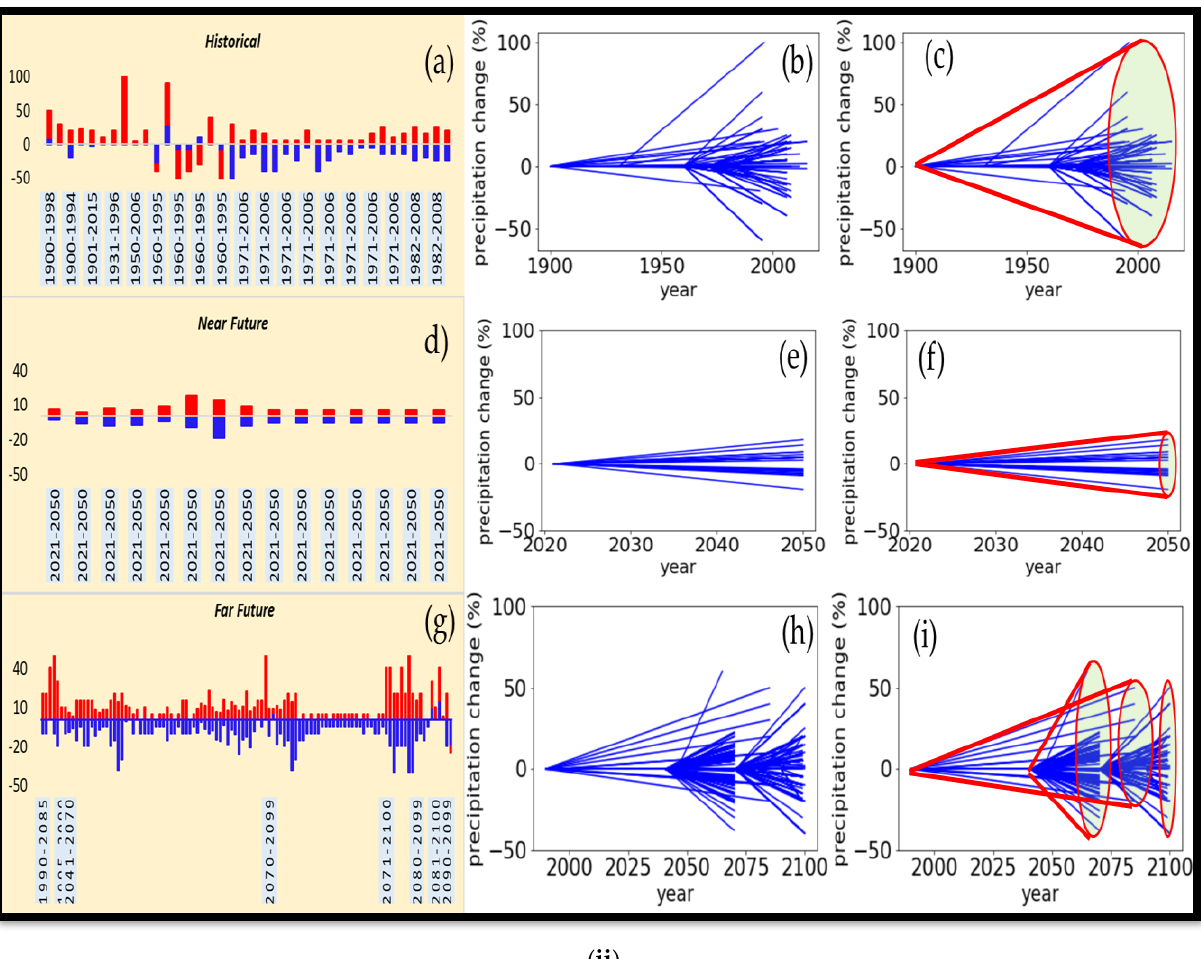
Figure 2. ( i ). The meta-analysis involved studies related to changes in temperature ( i ) and precipitation ( ii ) over the Ogallala Aquifer region and their potential impacts on agriculture and ecosystem services. The data are divided into historical, near future, and far future data for ease of representation. ( ia , id , ih ) represent the bar plots of the temperature changes from the 18 studies. The change in values was only observed in the bar plots. The period of the changes was identified from the scenario plots (blue lines) in ( ib , ie , ih ). The temperatures varied from − 4 °C to 8 °C. Historical models suggested a symmetrical steady shift from − 2 °C to +2 °C from 1900 to 2000. Temperatures rapidly rose by up to 5 °C, between 1980 and 2000. The spread of the scenario lines was more biased towards positive temperature changes after 2000. The scenario lines (blue lines) also showed that the number of values increased. This suggested that there was an increase in the number of studies related to climate change in the aquifer region. A rapid increase in temperature was observed in future projections ( ih ) until 2100 [37 – 39]. The funnel plots (red and green lines) are in ( c , f , i ). The mouth of the funnel (green) represents the spread of the scenario lines.